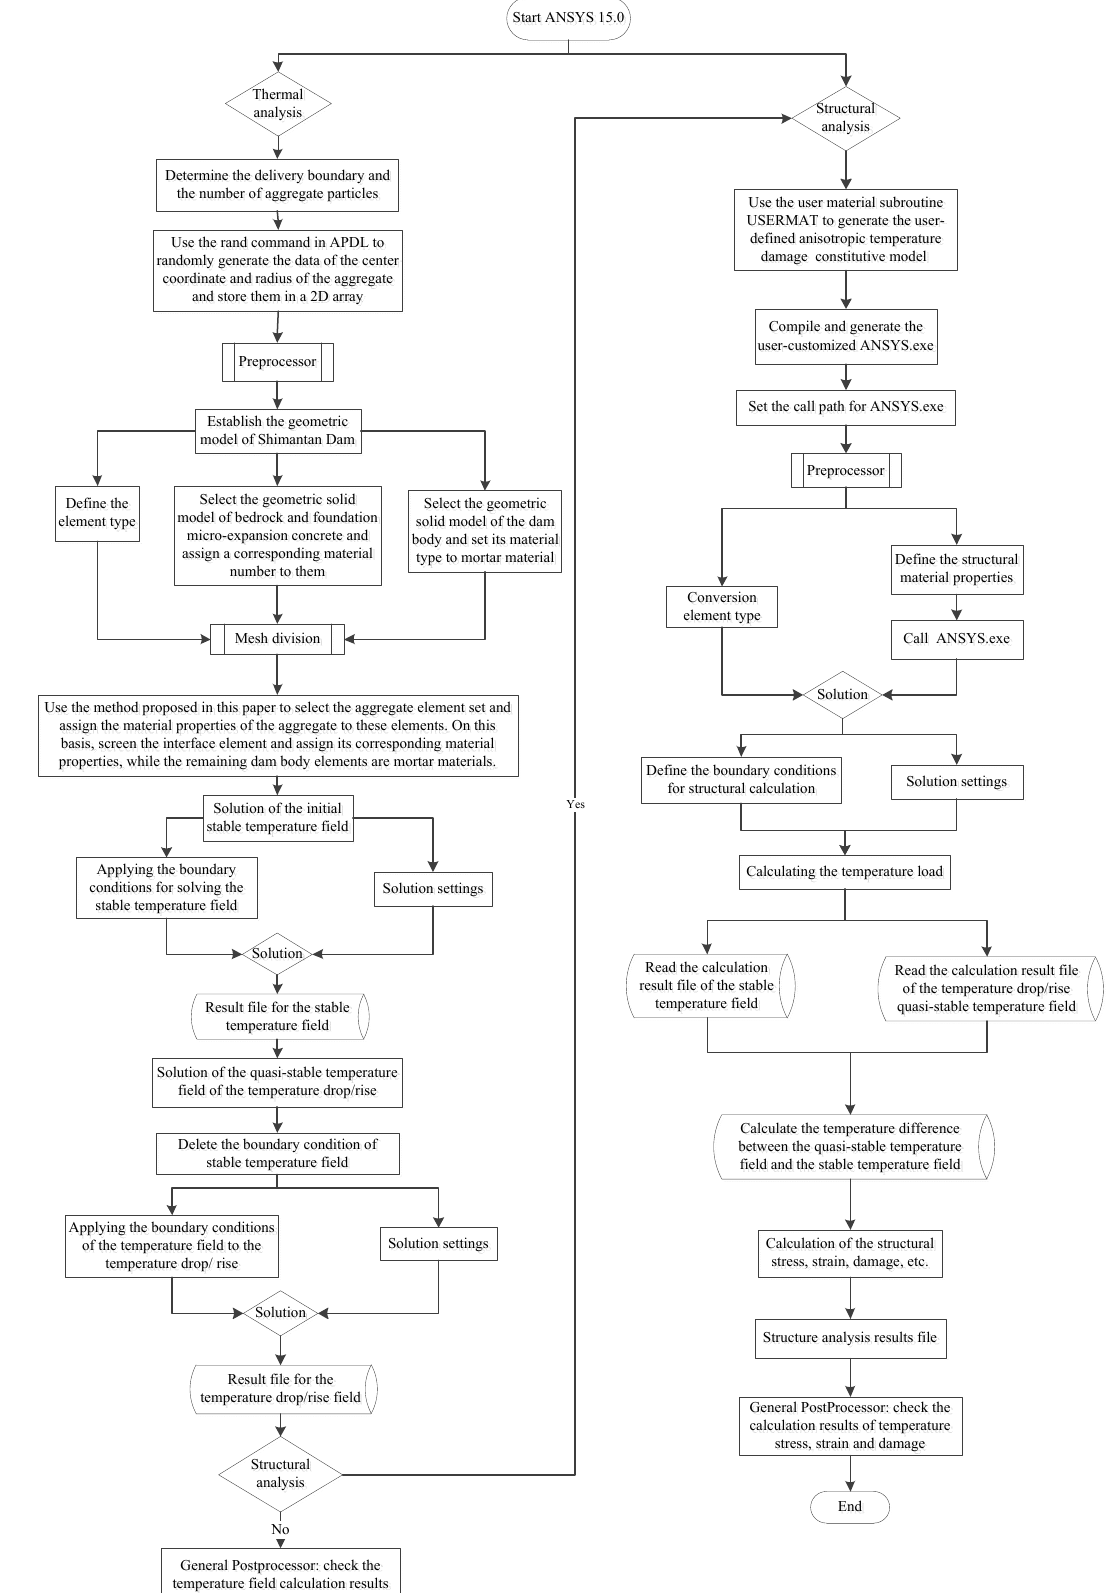
Figure 11. The flow chart of macro–meso model calculation.